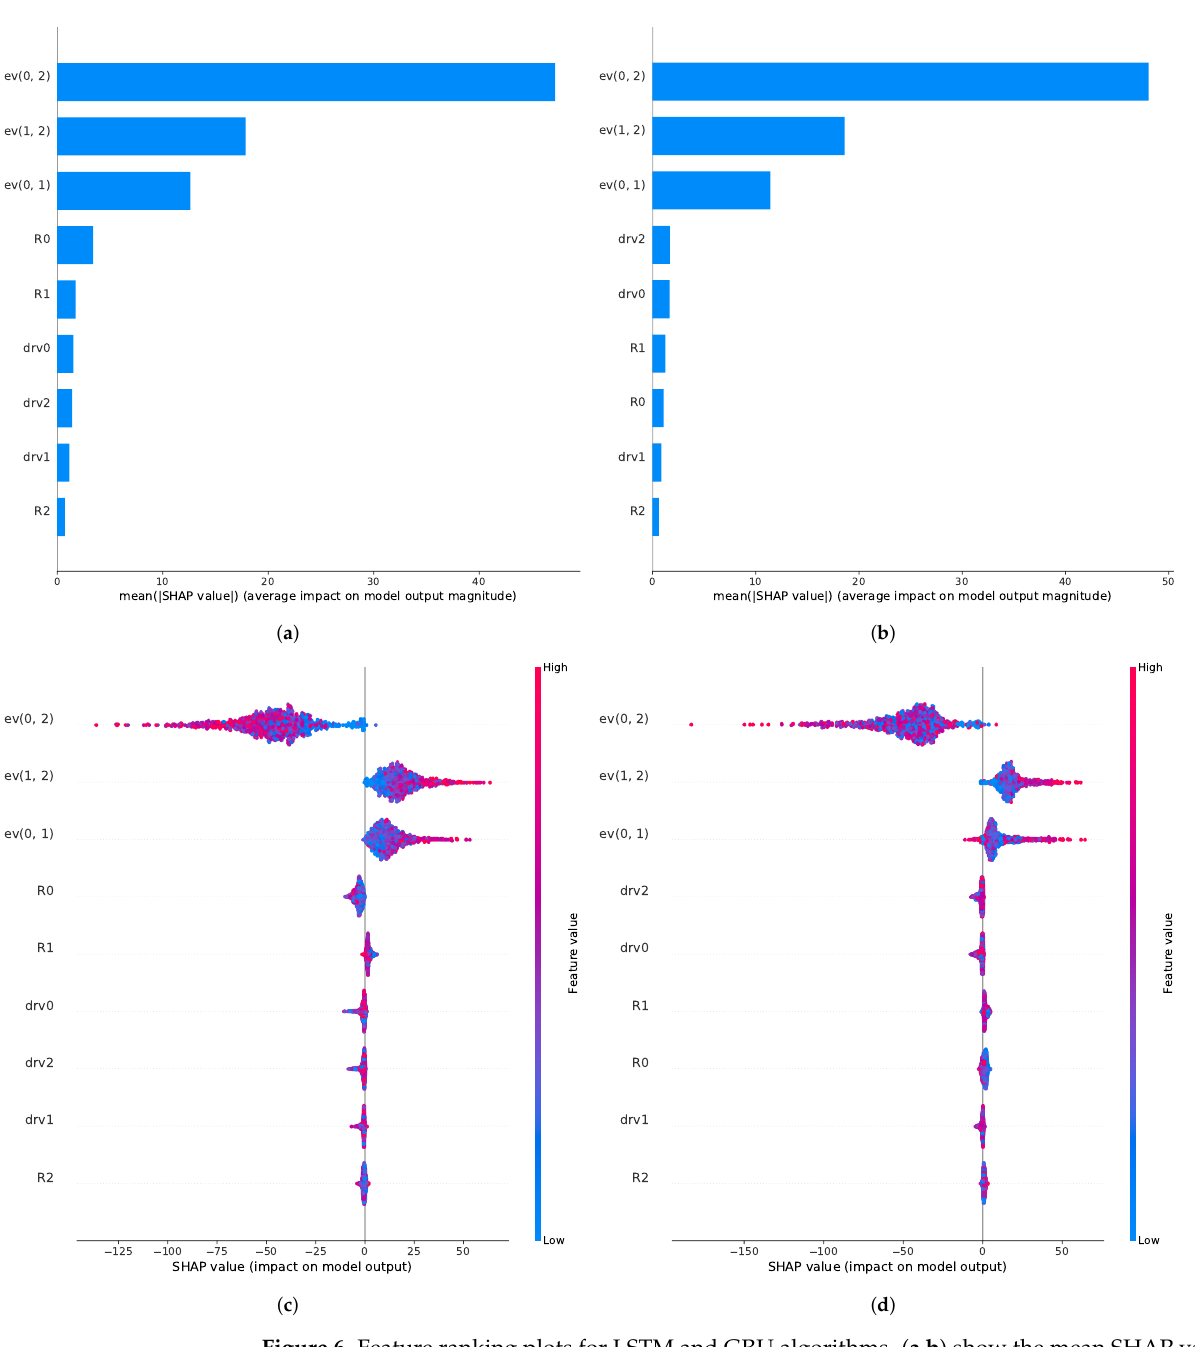
Figure 6. Feature ranking plots for LSTM and GRU algorithms. ( a , b ) show the mean SHAP values for the different features for ( a ) the LSTM and ( b ) the GRU model, respectively, and hence a ranking on the features. ( c , d ) provide an overview over the different SHAP values and their distributions for each individual feature and also illustrating the feature